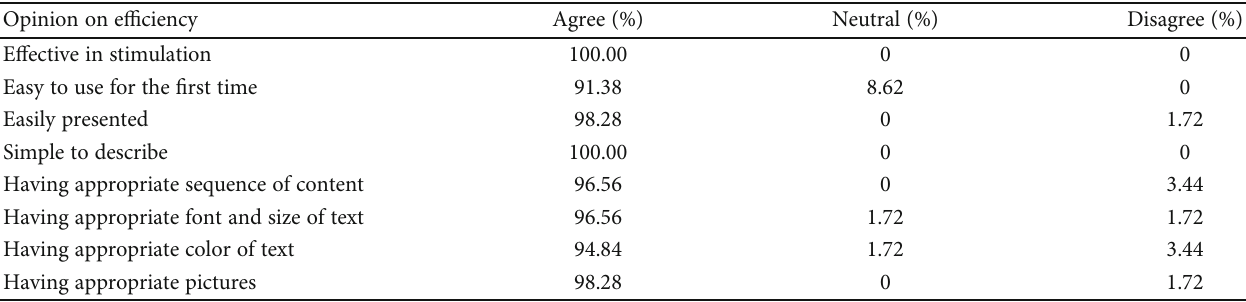
Figure 4: Process for developing the learning media. Table 2: E ffi ciency of the learning media ( n = 58